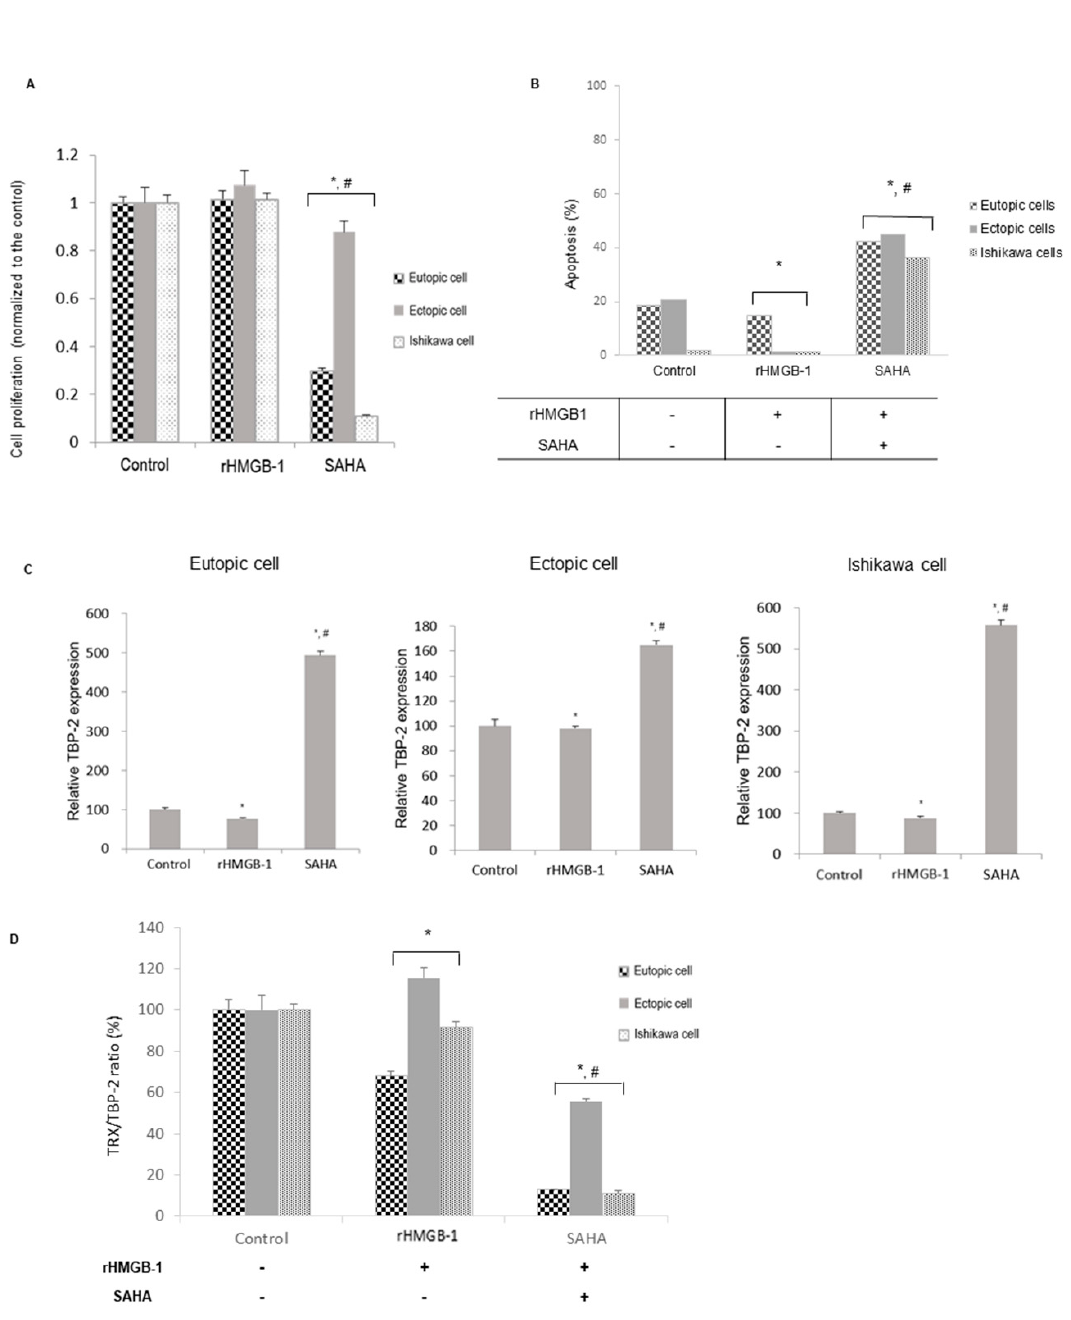
Figure 2. Endometrial cell proliferation and TRX, TBP-2 expression after SAHA treatment in stress-induced cells. Oxidative stress was applied using rHMGB-1 10 ng/mL for 24 h. ( A ) Endometrial cell proliferation was measured after 48 h of treatment with 2.5 µ M SAHA, which revealed slight increases in three types of cells. ( B ) The proportion of apoptotic cells was measured using flow cytometry. Apoptosis was decreased after treating with rHMGB-1, but was soon overwhelmed with SAHA treatment. ( C ) The relative mRNA expression levels of TBP-2 showed significant reductions after rHMGB-1 treatment compared to the controls. SAHA increased TBP-2 mRNA expression significantly. ( D ) The TRX/TBP-2 ratio was increased in ectopic HESCs after rHMGB-1 treatment only, and then significantly decreased after SAHA treatment. *, p < 0.05 compared to the control; #, p < 0.05 compared to the rHMGB-1-treated cells.